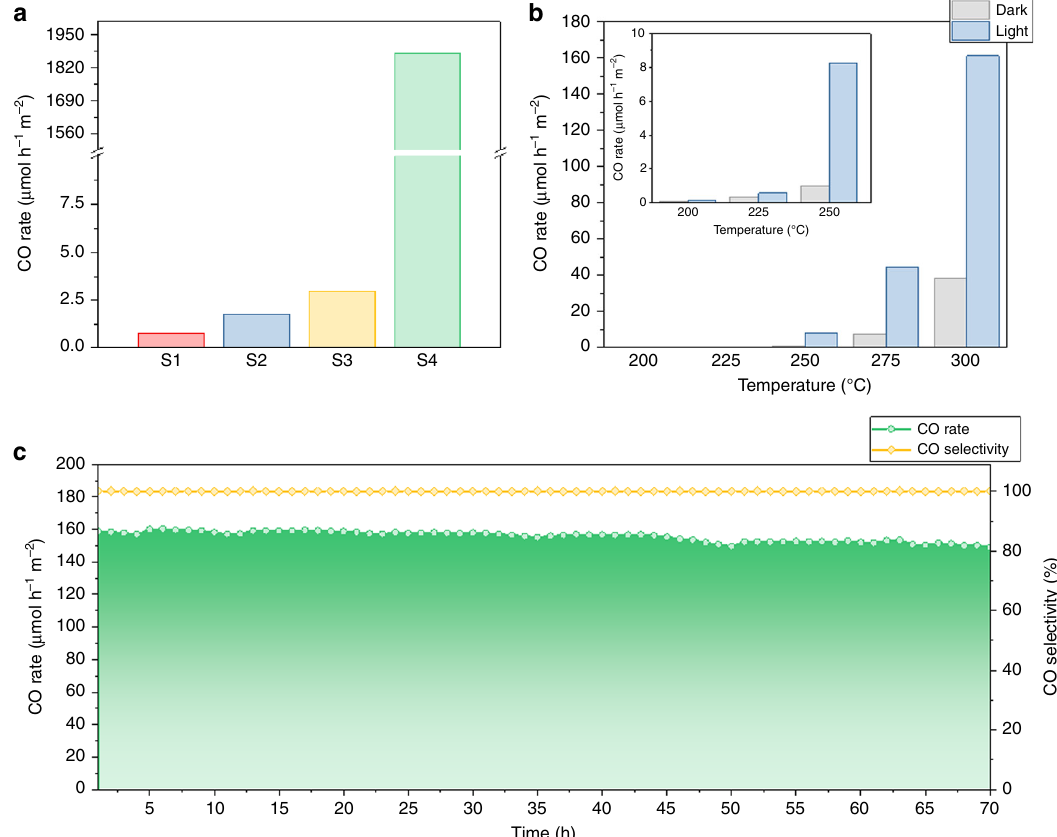
Fig. 3 Photocatalytic evaluation of black indium oxide. a Photocatalytic CO 2 hydrogenation in a batch reactor. Conditions: H 2 /CO 2 ratio = 1:1, light intensity = ~20 suns, no external heating and measurement time = 30 min. b Catalytic performance for S4 in a fl ow reactor at different temperatures, both with and without light irradiation; inset is the enlarged view of the catalytic performance for 200, 225 and 250°C. c Stability test for S4 in a fl ow reactor at 300 °C with light irradiation for 70 h. Conditions for fl ow measurement: atmospheric pressure, H 2 /CO 2 ratio = 1:1 with a fl ow rate of 1 mL min − 1 and light intensity of ~8